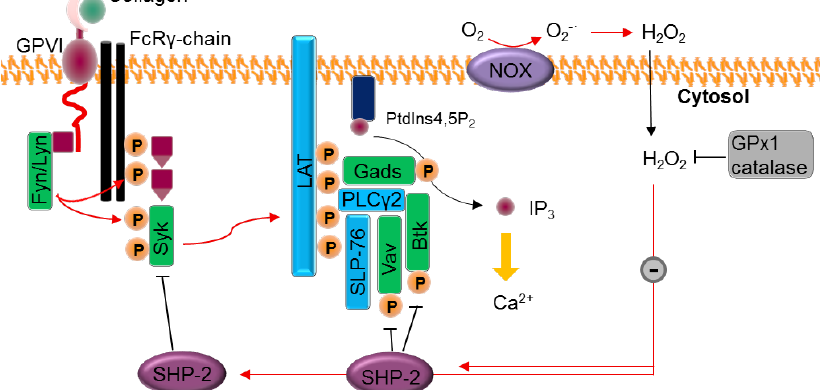
Figure 3. Ca 2+ mobilization upon stimulation with collagen agonists. Collagen induces the assembly of NOX complexes at the membrane. O 2−· is converted by SOD into the thiol effector and membrane permeable (black arrow) H 2 O 2 , which reversibly switches off the SHP-2 phosphatase SHP-2 cysteine oxidation inhibits its phosphatase function (black T bars) and results in enhanced (red arrows) kinases Syk, Vav1, and Btk phosphorylation, essential for the activation of membrane complexes such as PLC γ -2 and LAT and inducing IP 3 release in the cytosol. IP 3 acts on the calcium channel, mobilizing Ca 2+ (yellow arrow). Adapted from reference [31], courtesy of Tong-Shin